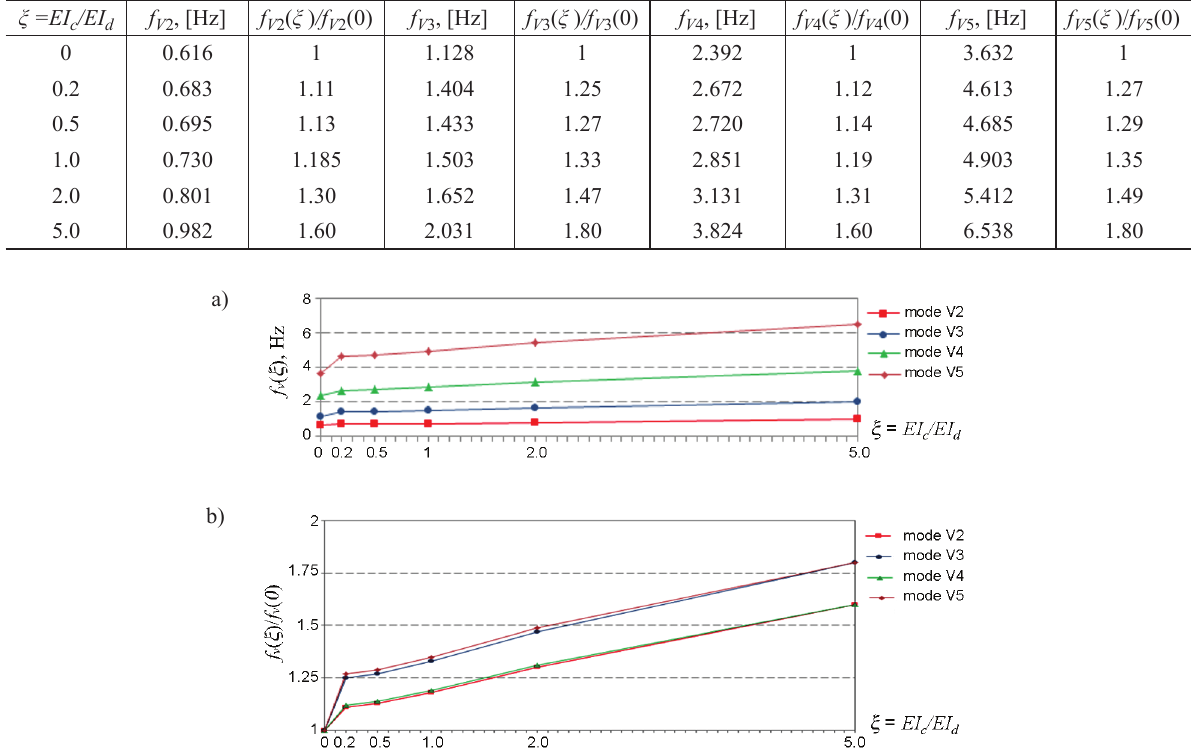
Table 2. Natural vibration frequencies and the frequency ratio of the first four vertical modes ξ =EI c /EI d